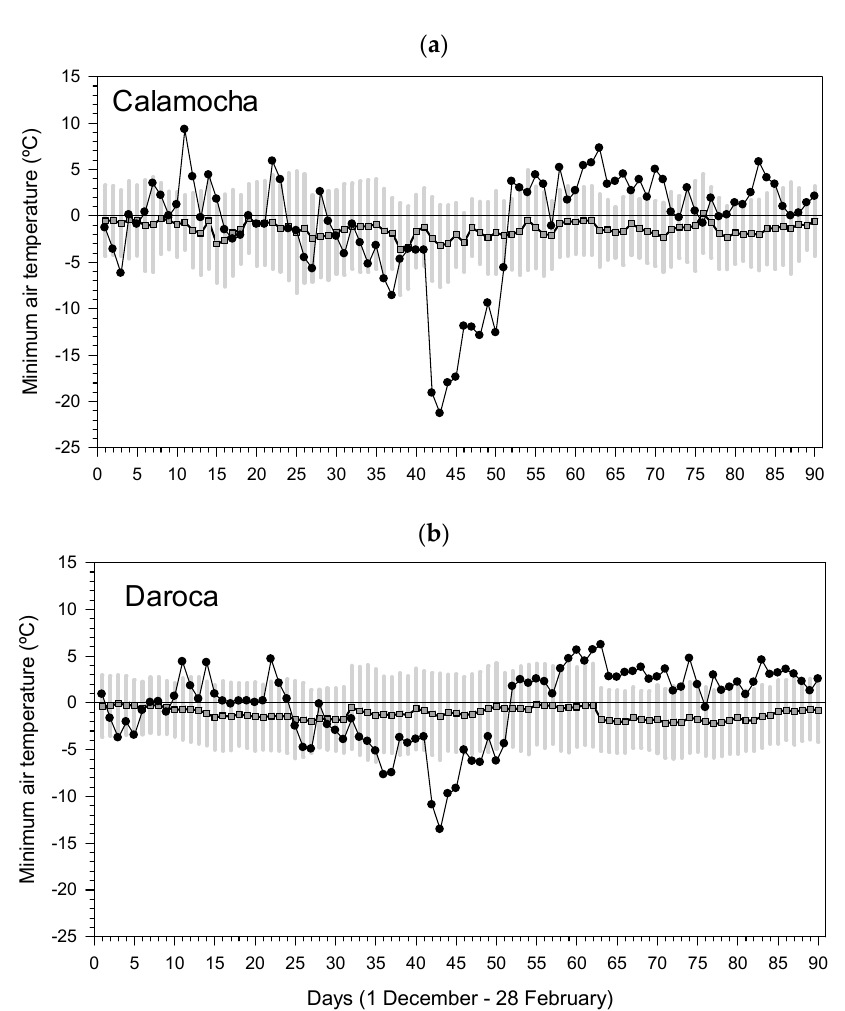
Figure 1. Daily means and values of minimum air temperatures recorded in the winter of 2020–2021 in ( a ) Calamocha and ( b ) Daroca meteorological stations. Black lines with solid dots are daily minimum air temperatures during 1 December 2020–28 February 2021. Error bars are means ± standard deviation ( a ) during 1993–2019 for Calamocha and ( b ) during 1920–2019 for Daroca.